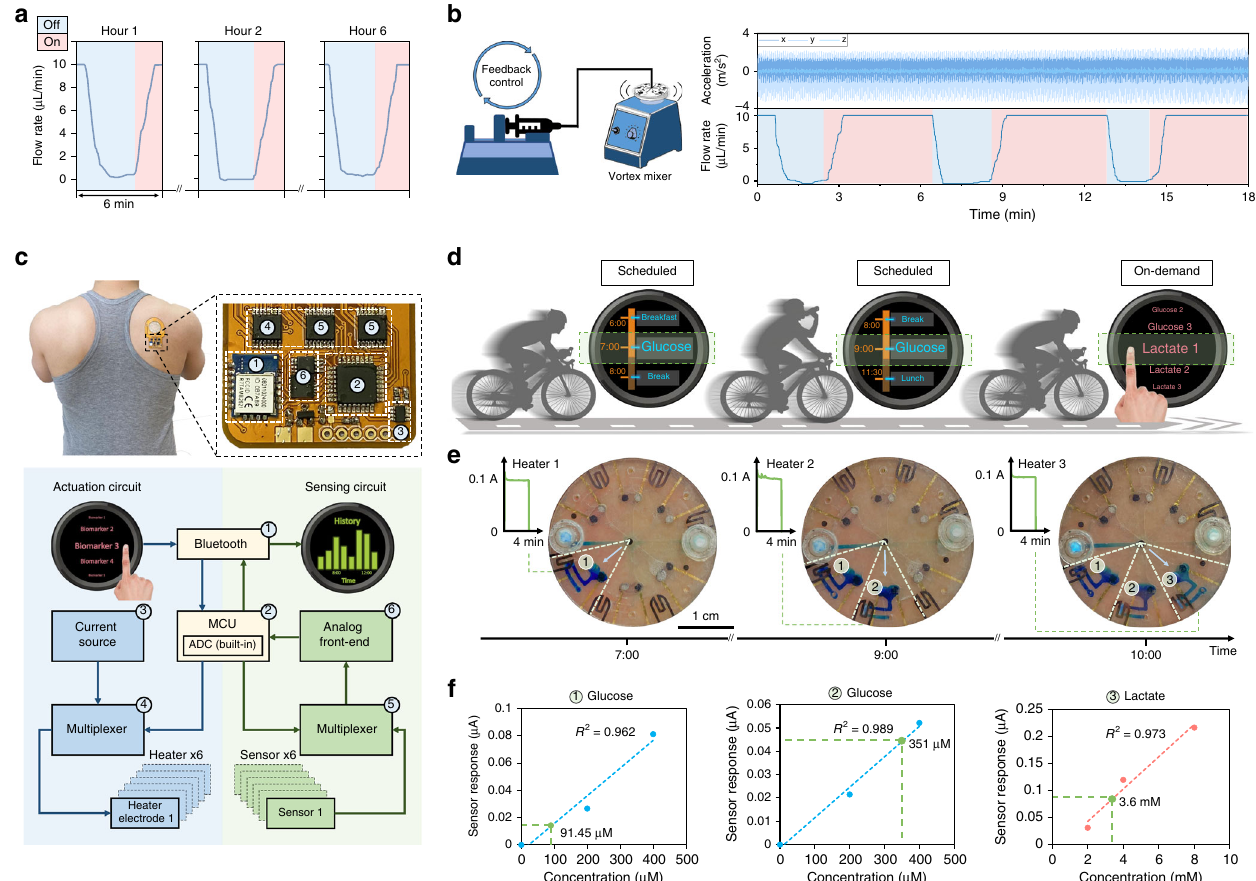
Fig. 5 Integration and characterization for contextually relevant on-body biomarker analysis. a Ex situ characterization of the prolonged operation of the pressure-regulated valve (performed over 6 h). b Ex situ characterization of the high- fi delity operation of the pressure-regulated valve in the presence of vortical vibration. The vibrational acceleration pro fi les are presented in the top half, and the characterized fl ow rate pro fi le is captured in the bottom half. c Optical image of a representative fully integrated programmable epidermal micro fl uidic valving system applied on the back of a subject with a zoomed-in view of the FPCB electronic components. The block diagram details the circuit-level valve actuation and signal-processing operations. d Illustration of the planned study for scheduled/on-demand sweat sampling during physical activity (cycling). e Optical images of intermittently sampled, routed, and compartmentalized sweat on-body (visualized with the aid of blue dyes, embedded within the compartments). Three valves were sequentially activated/ deactivated at programmed timepoints during a physical exercise. The inset fi gures show the characterized electrical current through the respective valves ’ microheaters (activated for 4 min). f Measured sweat glucose and lactate concentrations based on-body sensor readouts (green data points). The corresponding calibration curves (dashed lines) were constructed by linear fi tting the measured sensor responses to three reference samples with known analyte concentrations (blue/red data points in the case of glucose/lactate sensors). Sweat glucose readouts were obtained by the valve-gated sensing compartments 1 and 2, before and after a scheduled beverage intake event, respectively. The sweat lactate readout was obtained by the valve-gated sensing compartment 3 upon on-demand user